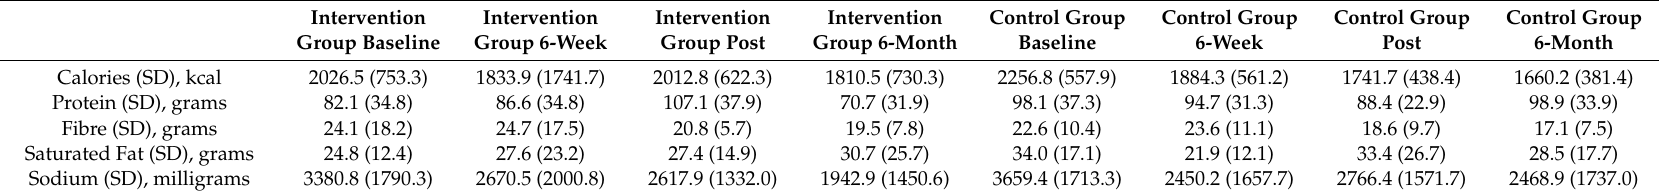
Table 5. Parent Nutritional Variables for Intervention and Control Groups, at Baseline, Mid Intervention, Post Intervention, and 6-Month Follow-Up. Intervention Group